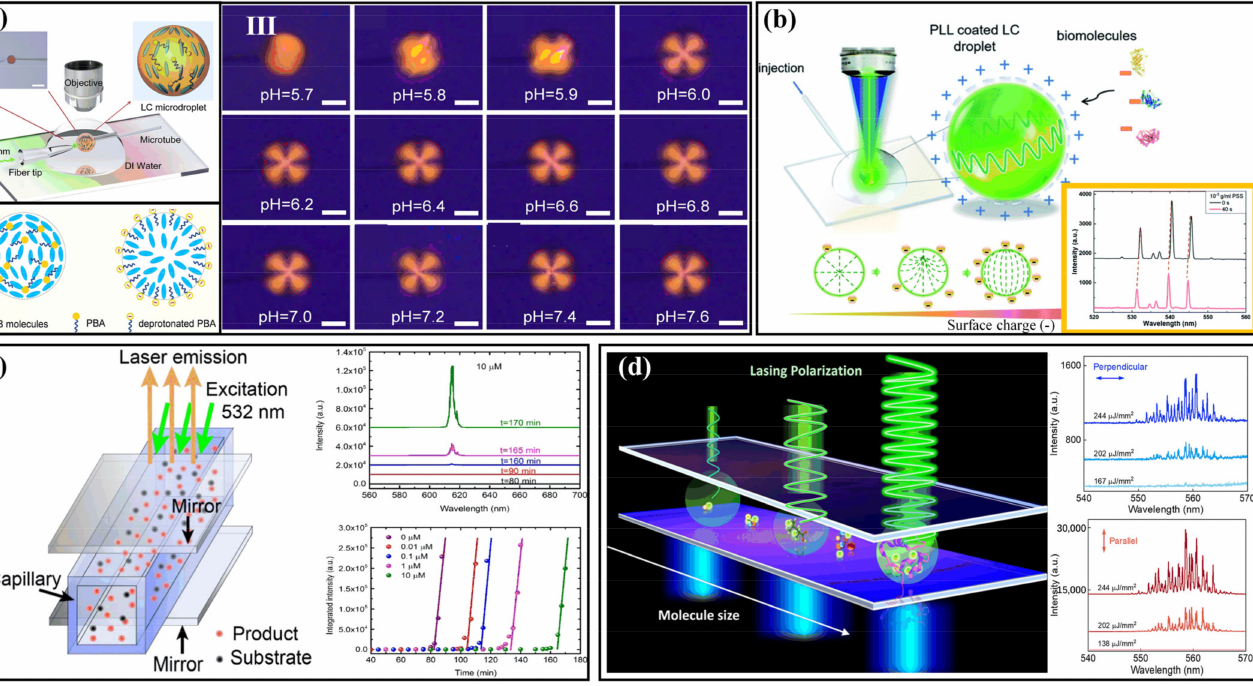
Figure 2. Environment and molecular detection with biolasers. ( a ) I: Schematic diagram of liquid crystal (LC) microlaser setup. II: Schematic diagram of structural change of microdroplets based on PBA-doped 5CB with different pH values (5.7, left; 6.0, right). III: Polarized optical microscope (POM) figures of the microdroplets based on PBA-doped 5CB in PBS solution with distinct pH values. Scale bars 20 µ m. (Adapted with permission from [34]. Copyright 2017 Elsevier B.V.) ( b ) The fixed LC C6-doped microdroplet was pumped with a laser. The microdroplets were coated with PLL solution to create a surface with a positive charge, which attracts molecules with negative charges. Inset marked in orange: lasing spectra collected before and after adding PSS solution to the LC microdroplet. (Adapted with permission from [43]. Copyright 2020 The Royal Society of Chemistry.) ( c ) Lasing cavity frame of the optofluidic catalytic laser, emission spectra, and threshold times of the optofluidic catalytic laser with different S 2 − concentrations. (Adapted with permission from [30]. Copyright 2017 Elsevier B.V.) ( d ) Schematic diagram of FP microlaser. Molecules are sandwiched with an FP cavity. Spectrum figures show the difference between perpendicular and parallel polarized lasing of fluorescein binding with glycine. (Adapted with permission from [51]. Copyright 2020 American Chemical